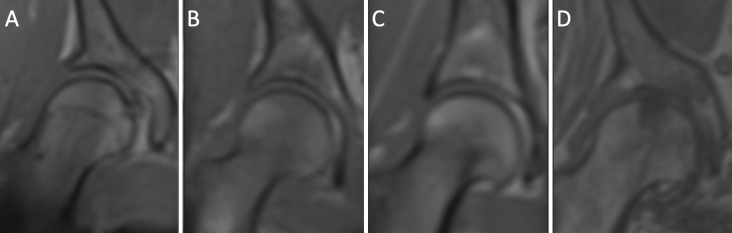
Examples of T1 vibe dixon in phase of the degenerative states of the OA MRI score.A: Grade 0 –no degeneration; B: Grade 1 –Slight narrowing of the medial joint gap and small osteophytic lipping; C: Grade 2 –narrowing of the medial joint gap and increased osteophytic lipping; D: Grade 3 –loss of the medial joint gap, osteophytic lipping as well as pseudocystic lesions.